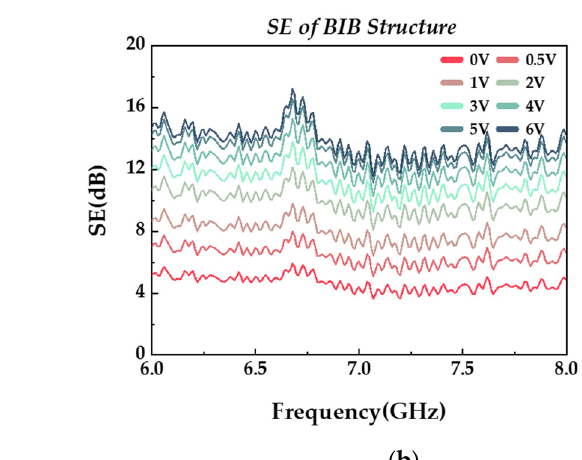
Figure 6. Shielding effectiveness of the ( a ) MIM and ( b ) BIB structure with different voltages.